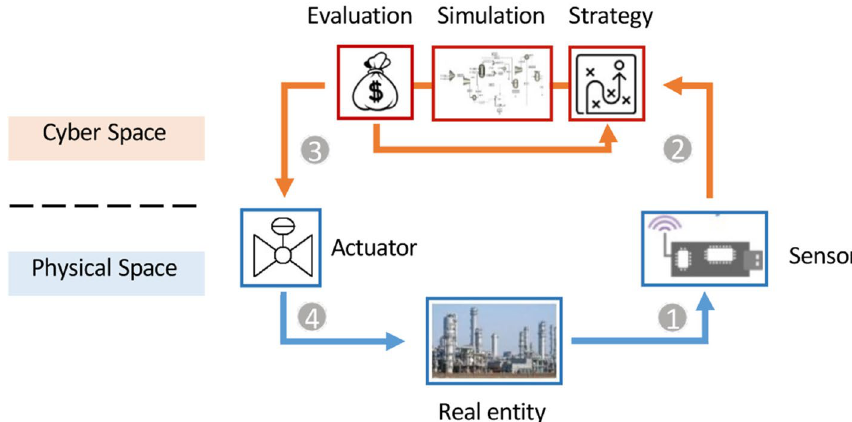
Fig. 1 Architecture of cyber-physical system enabled